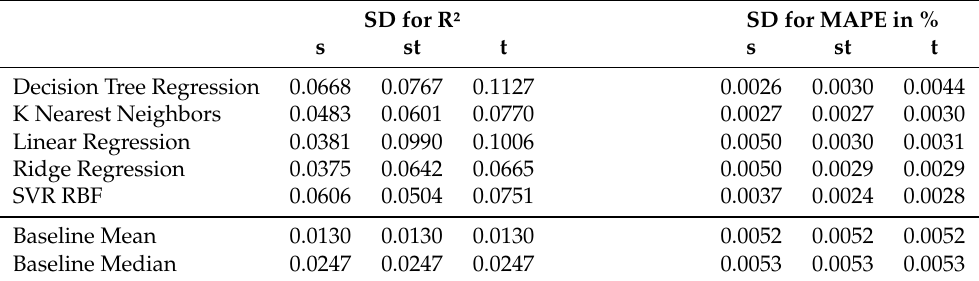
Ridge Regression